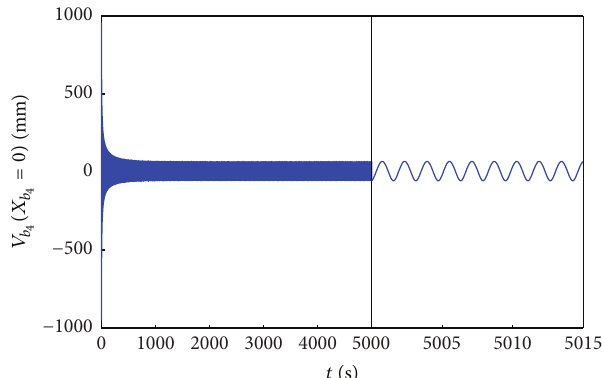
Figure 17: Time response of the midpoint of the deck beam, 𝑞 1 (0) = 3 and 𝑁 = 1 .